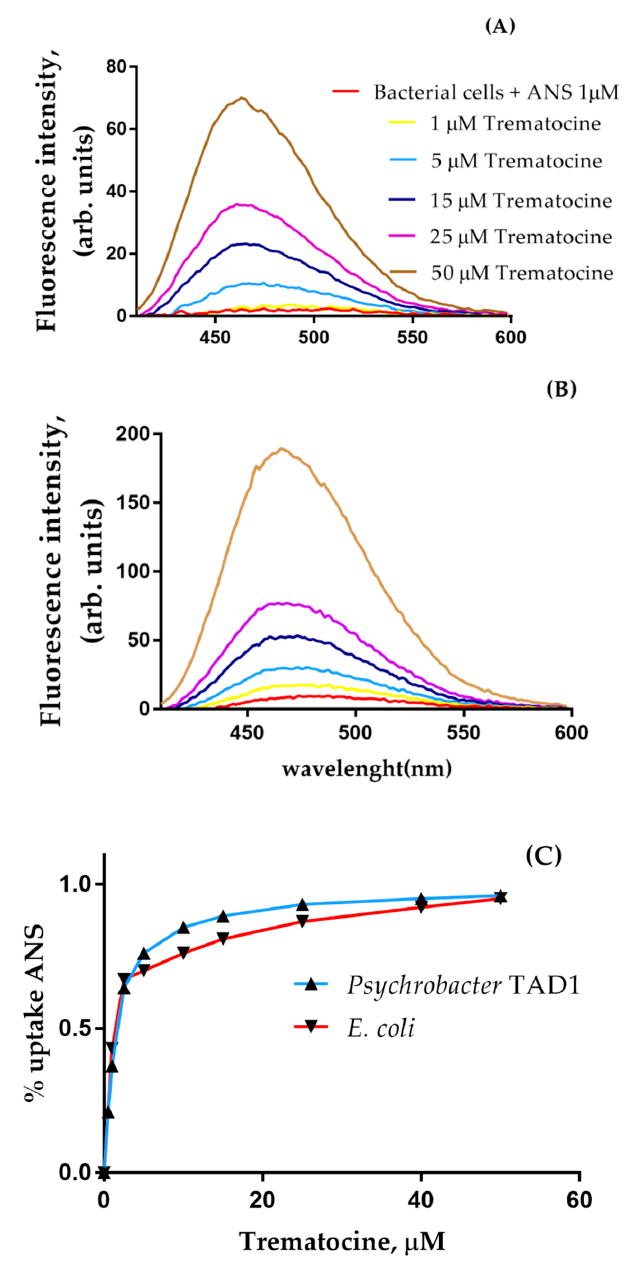
Figure 8. Permeabilization of Psychrobacter TAD1 ( A , B ) E. coli , outer membrane by Trematocine. ( C ): percentage of ANS uptake.